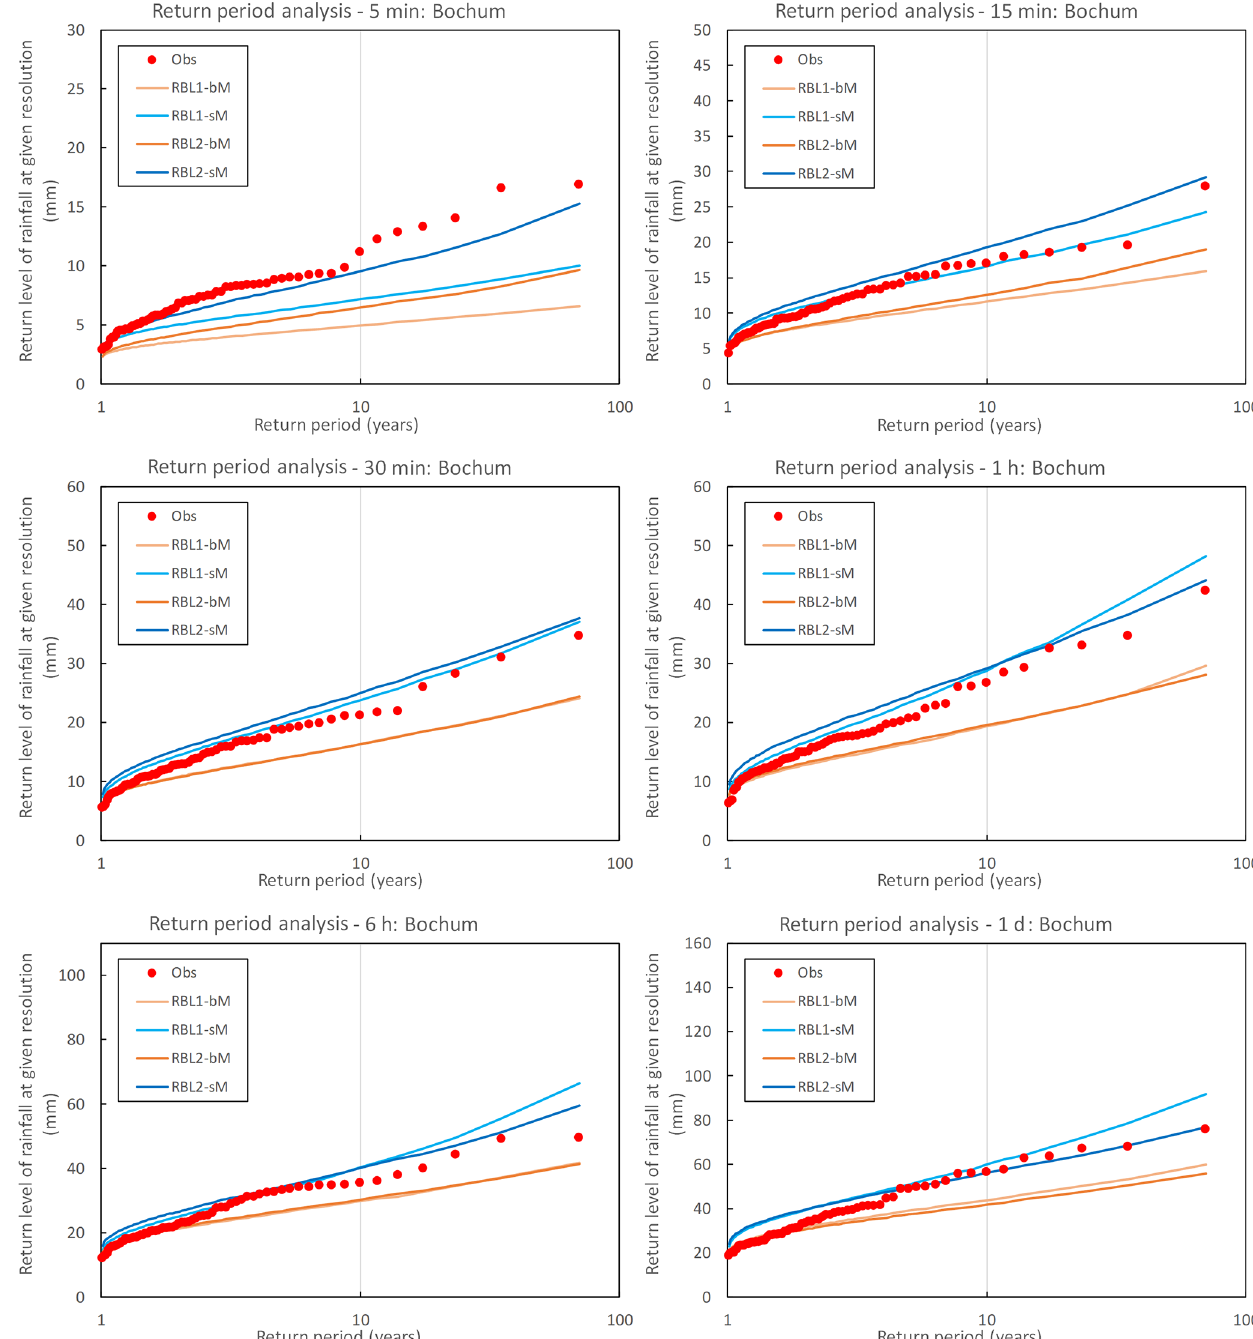
Figure 6. Observed (round markers) and simulated (lines) return levels of rainfall at different timescales at Bochum. The simulated return level is sampled from the RBL1 and RBL2 models fitted with selected statistical properties calculated using bM and sM methods, respectively. The median return levels obtained from 250 simulations, each of 69 years, are